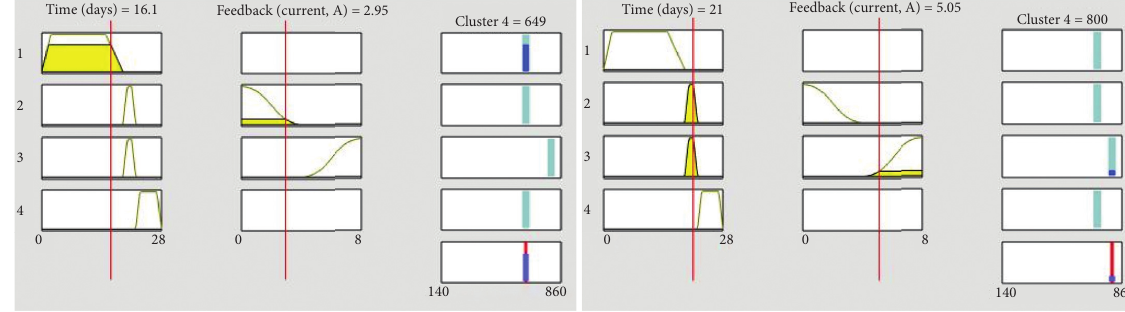
Figure 14: Output result representation of off-peak and peak points for cluster 4.